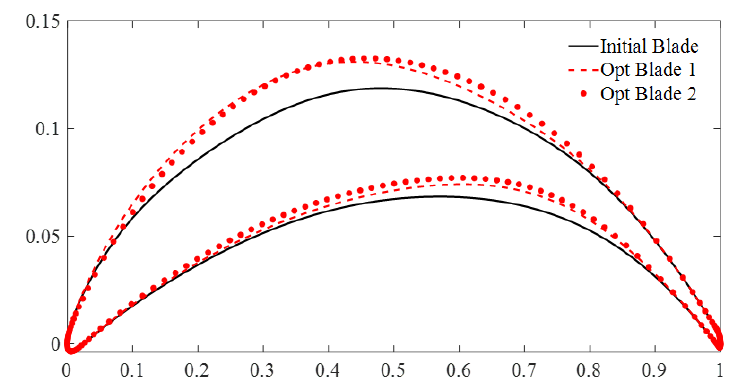
Figure 16. The shape comparison of original blade profiles and two optimized blade profiles with different design objective formulations.